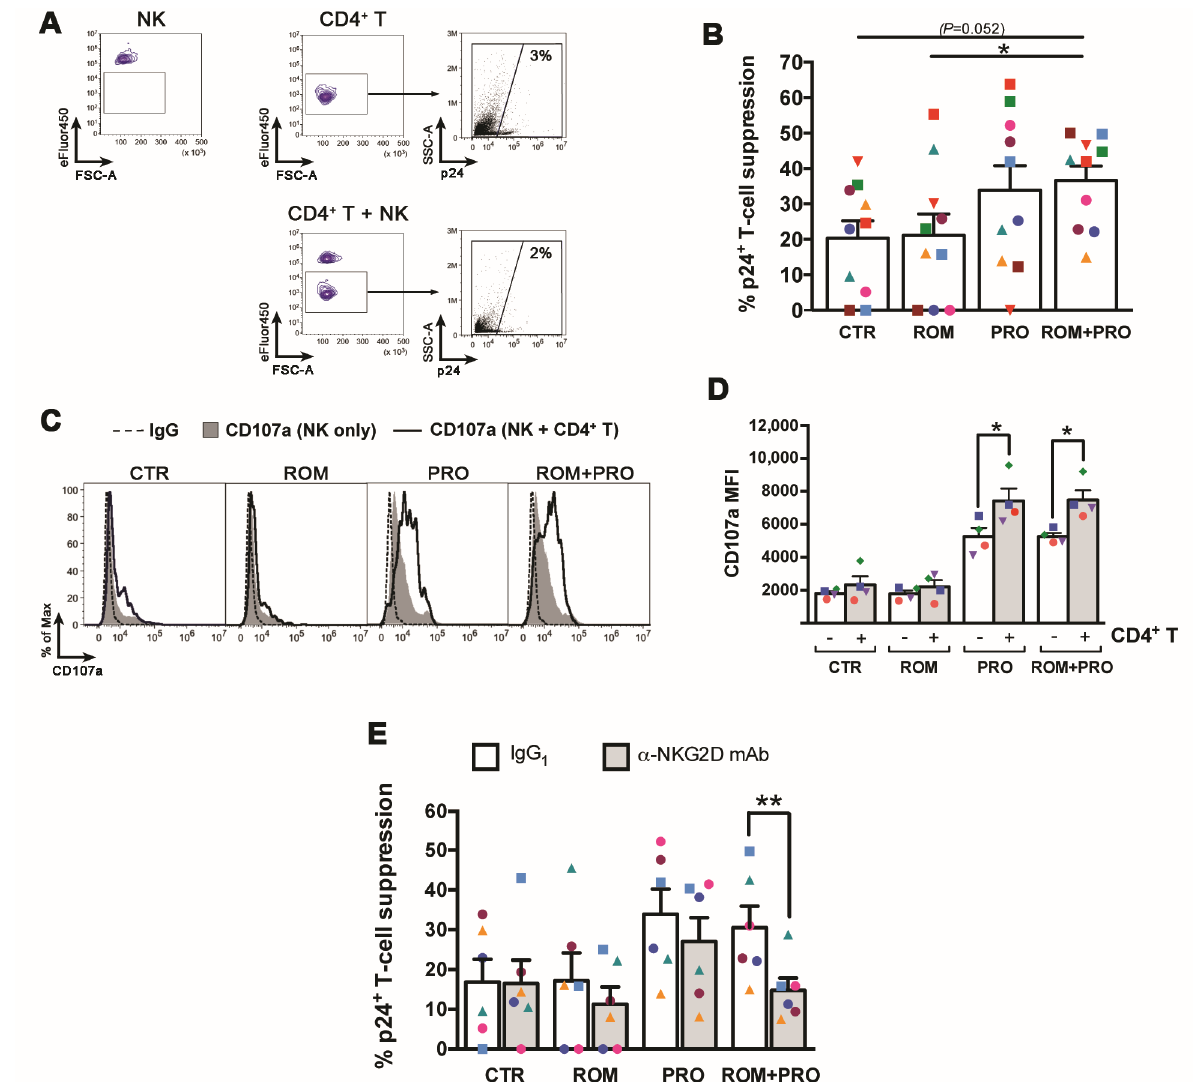
Figure 5. Clearance of reactivated HIV + T cells by NK cells in the presence of Prostratin and/or Romidepsin. A viral suppression assay was set up in which latently infected CD4 + T cells (targets, T) were stimulated with ROM, PRO, ROM/PRO or not stimulated (CTR) for 72 h with and without the addition in the last 18 h of autologous eFluor450-labeled, equally stimulated/not stimulated NK cells (effectors, E) at an E:T ratio of 1:1. The T and T+NK cell cultures were analysed by flow cytometry to measure the frequency of p24 + cells among gated eFluor450 - targets and calculate the percentage of NK-cell mediated suppression (see Materials and Methods). ( A ) The gating strategy is shown for a representative set of not stimulated autologous NK cells and CD4 + T cells cultivated separately or together for the last 18 h. ( B ) The % of p24 + cell suppression by NK cells in CTR, ROM, PRO, and ROM/PRO co-cultures was calculated in 10 independent experiments. ( C , D ) NK cell degranulation was measured by including anti-CD107a mAb or IgG control to T+NK and NK cell cultures in the last 18 h; ( C ) CD107a expression among eFluor450 + NK cells cultivated without (filled gray) or with CD4 + T cells (open black histograms) is shown together with control IgG signal (dashed line) for a representative experiment; ( D ) CD107a MFI measured in 4 independent experiments is shown. ( E ) The suppression of p24 + cells by NK cells pre-incubated with anti-NKG2D mAb or control IgG 1 was measured in 6 different donors as described in panels ( A , B ). Bars represent mean ± SEM. Each symbol corresponds to one donor. * p < 0.05, ** p < 0.01 by paired t test.